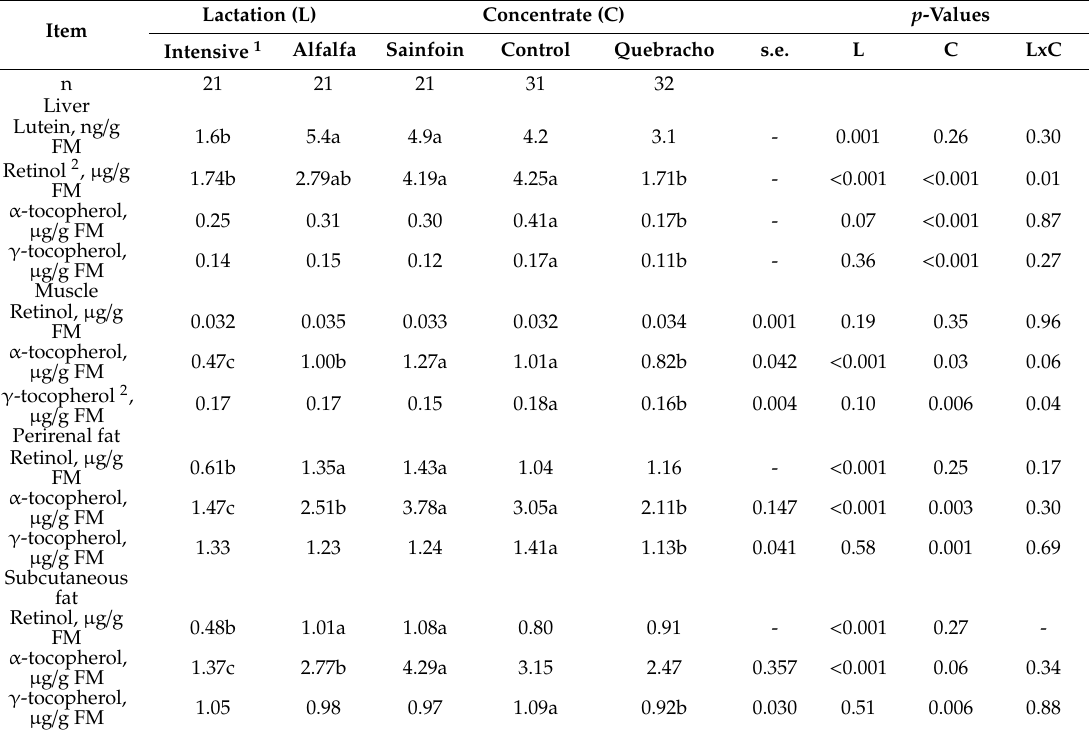
Table 3. E ff ect of the maternal feeding during lactation and the concentrate during fattening on the deposition of lutein, retinol and tocopherol in the tissues of the light lamb. Lactation (L) Concentrate (C) p -Values Item